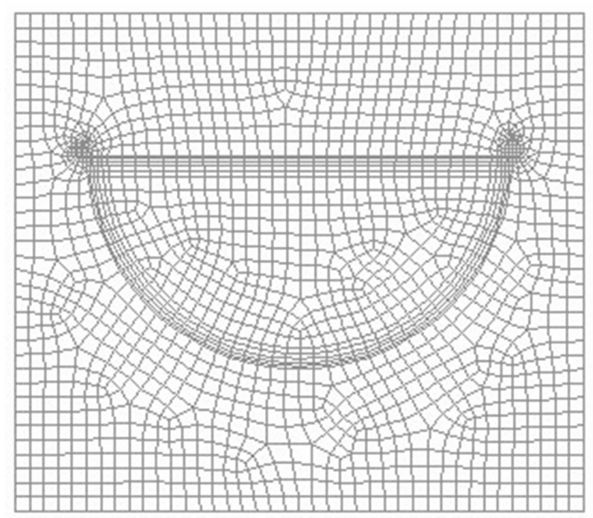
Figure 9. Sectional view of the mesh for computational model.